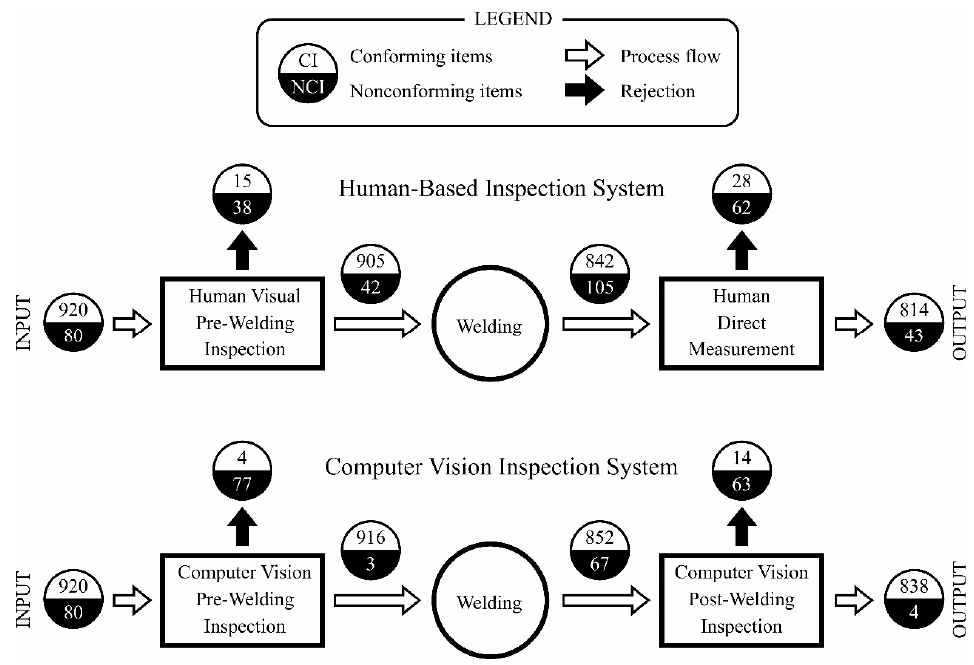
Table 3. Methods comparison.